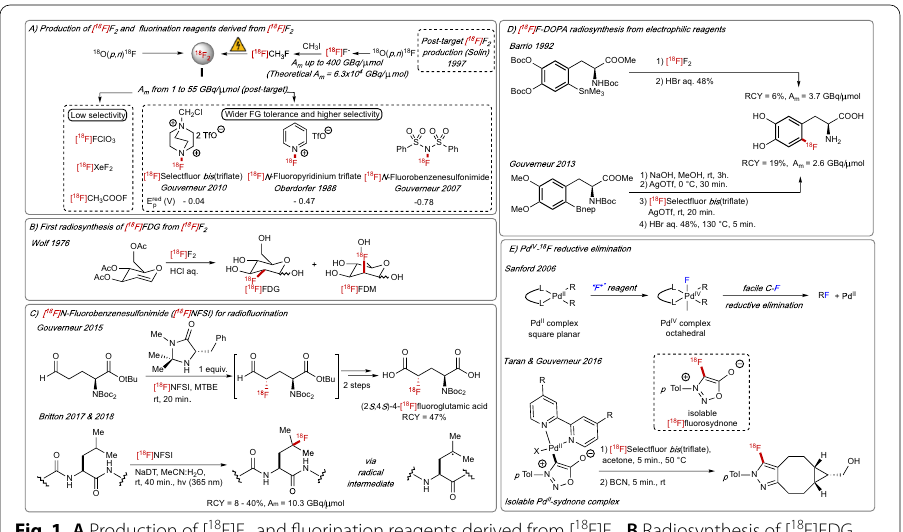
Fig. 1 A Production of [ 18 F]F 2 and fluorination reagents derived from [ 18 F]F 2 . B Radiosynthesis of [ 18 F]FDG from [ 18 F]F 2 . C Radiolabelling of aminoacids and peptides with [ 18 F]NFSI. D Radiosynthesis of [ 18 F]FDOPA. E Radiofluorination of [Pd II ]-sydnone complex. MTBE Bnep boronate neopentylglycol ester. BCN =